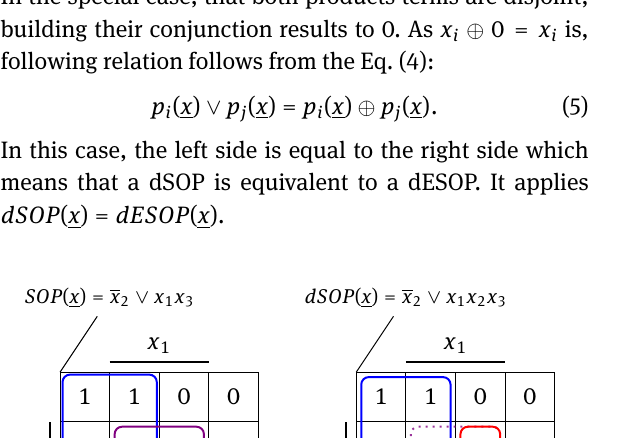
Figure 2: ⊖ : Two procedures in one step